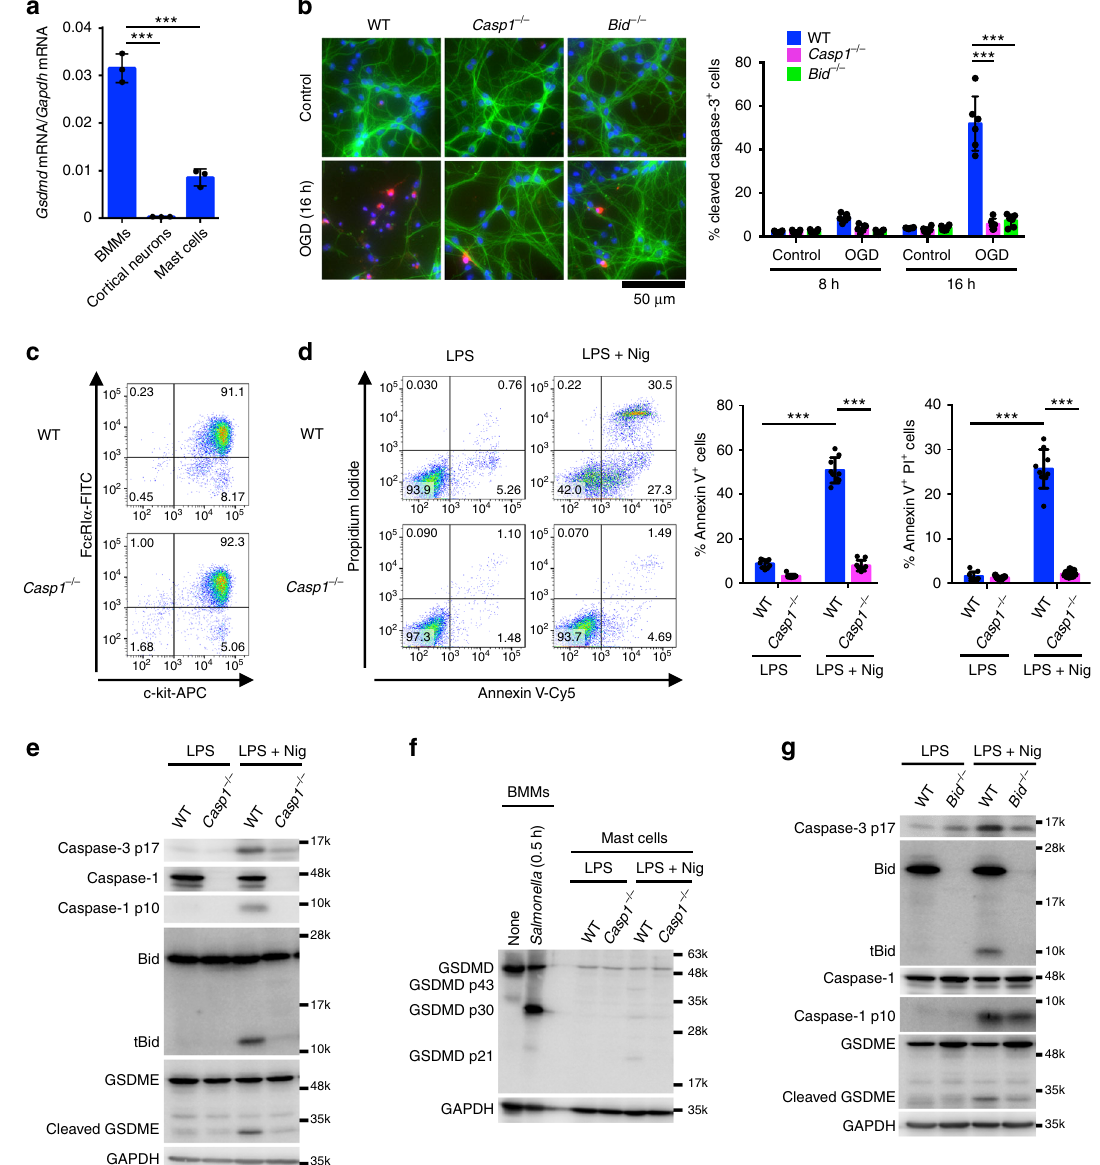
Fig. 10 Caspase-1 induces apoptosis in primary cortical neurons and mast cells. a Quantitative RT-PCR analysis of GSDMD mRNA expression in BMMs, cortical neurons, and bone marrow-derived mast cells. GSDMD mRNA expression was calculated relative to GAPDH mRNA (the Δ Ct method). Data are from three biologically independent experiments. b Primary cortical neurons were exposed to OGD for 8 and 16 h, and the cells were processed for immuno fl uorescent labeling of cleaved caspase-3 (red), β III-tubulin (green), and nuclei (blue). Representative fl uorescent microscopic images from three biologically independent experiments are shown. The graph depicts percentages of cleaved caspase-3 + cells (six fi elds, >900 cells per group). c Surface expression of Fc ε RI α and c-kit in mast cells was determined by fl ow cytometry. d – g Mast cells of the indicated genotypes were primed with LPS (100 ng ml − 1 ) for 3 h and then stimulated with nigericin (10 μ M) for 0.5 h ( e – g ) or 1 h ( d ). Flow cytometric analysis of PI uptake and PS exposure ( d ). Western blot detection of caspases, Bid, and GSDMs in cell lysates ( e – g ). In c – g , representative fl ow cytometry pro fi les ( c , d ) and Western blot images ( e – g ) from three biologically independent experiments are shown. In d , percentages of Annexin V + cells and Annexin V + PI + cells ( n = 9) are plotted. In a , b , and d , columns and bars represent the mean ± SD. Statistical signi fi cance was determined using the Bonferroni ’ s multiple comparisons test ( a , b , and d ). *** p < 0.001. Source data are provided as a Source Data fi